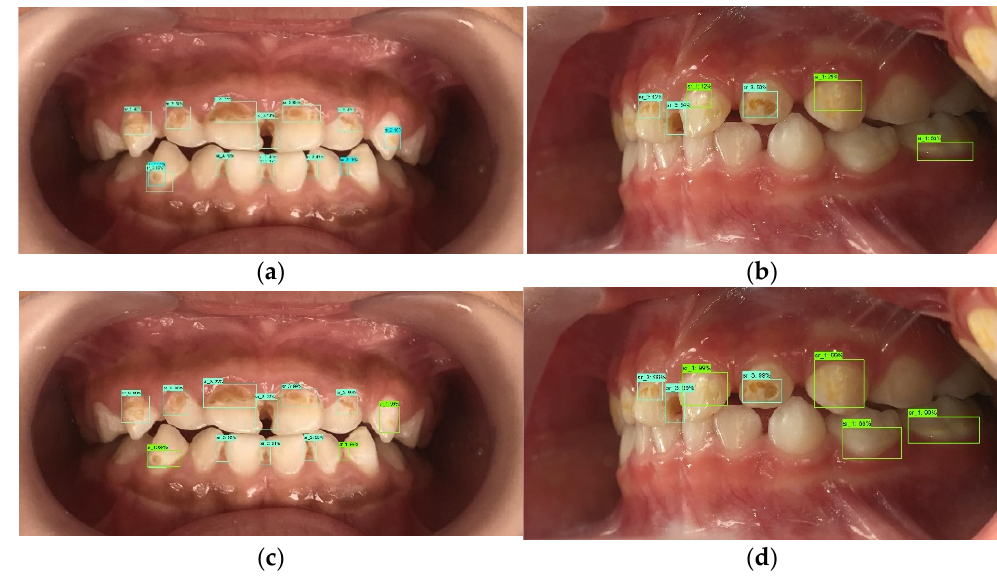
Figure 1. Central view ( a , c ) and lateral view ( b , d ) photos with non-cavitated (in green boxes) and cavitated lesions (in blue boxes) diagnosed by deep learning models (YOLOv3, Faster R-CNN).